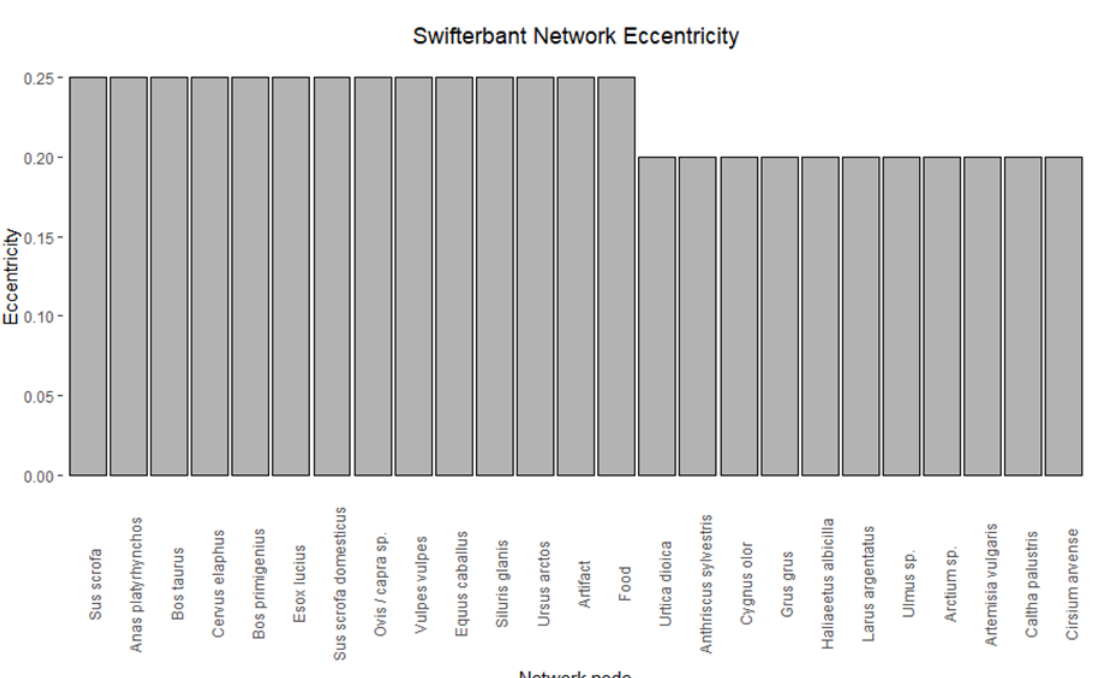
Figure 5. Network bridging centrality (top 25).